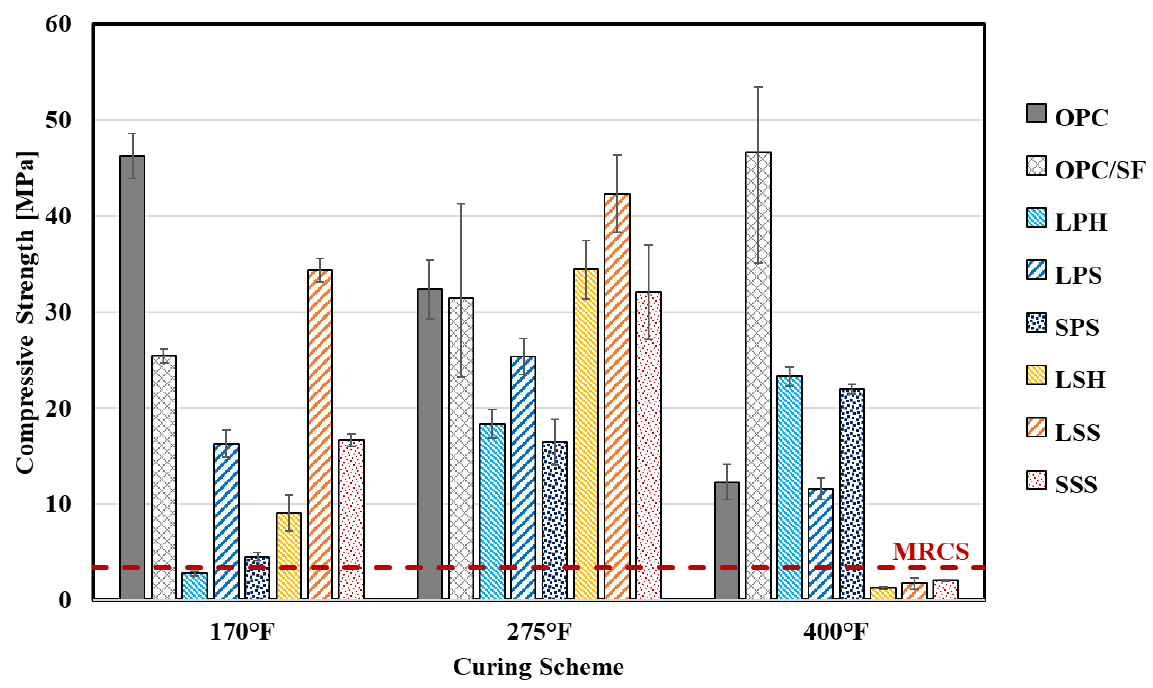
Figure 2. Three-day compressive strength for OPC and geopolymer formulations cured with different curing schemes (indicated by BHST value, see Table 3). Error bars represents the range of compressive strengths values measured for each mixture. Minimum Required Compressive Strength (MRCS) in accordance with standard API 10A is indicated by a dotted line.